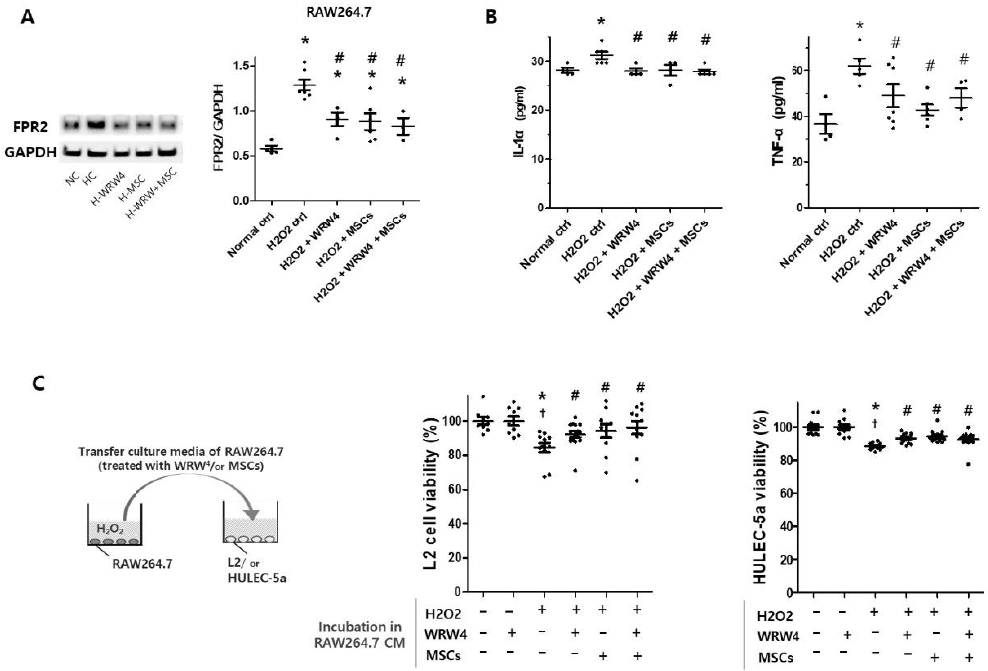
Figure 1. The effects of MSCs and FPR2 inhibitor, WRW4, on RAW264.7 cells’ inflammatory reac- tion. ( A ) Levels of FPR2 normalized to GAPDH loading control (Full length Western blots are shown in Supplementary Figure S3) and ( B ) inflammatory cytokines, such as IL −1α and TNF−α, were meas- ured in RAW264.7 cells, 12 h after H 2 O 2 (100 μM) induction, with or without WRW4 (10 μM) and